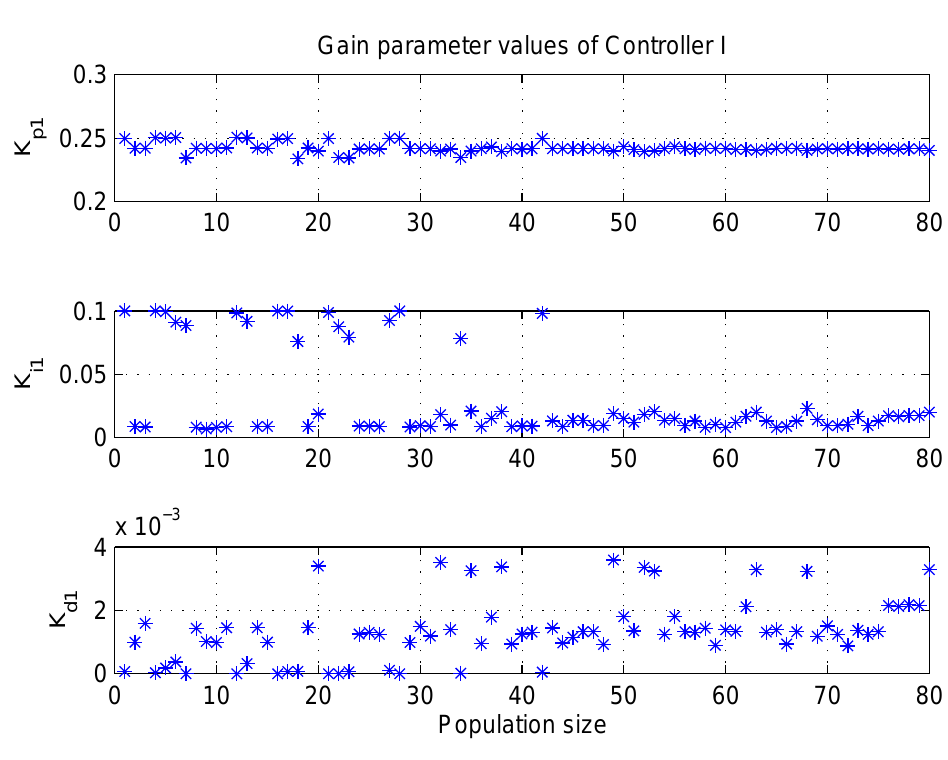
Figure 7. PID gain parameters of 1 th loop at each